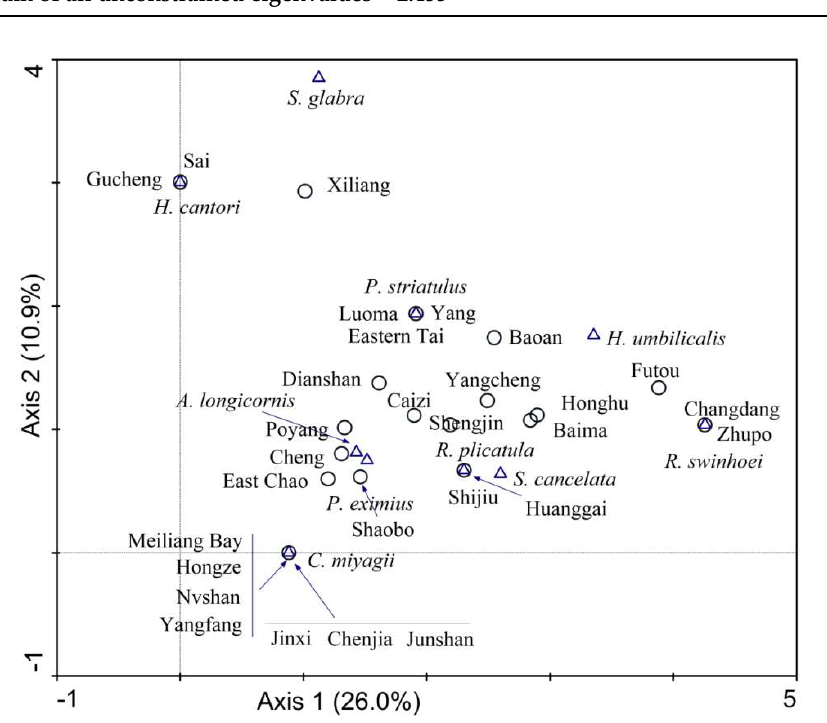
Figure 6. Detrended correspondence analysis (DCA) of subfossil gastropods in 32 surface sediment samples. Open triangles represent gastropod species and open circles represent the study sites.